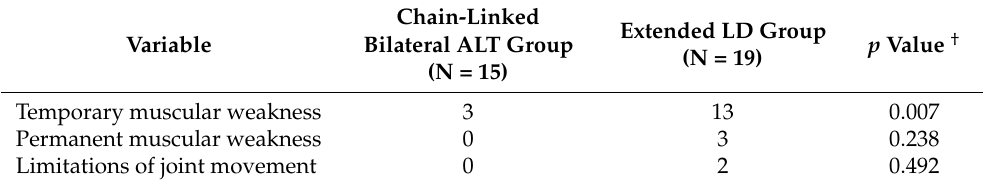
Table 5. Subjective assessment of donor site